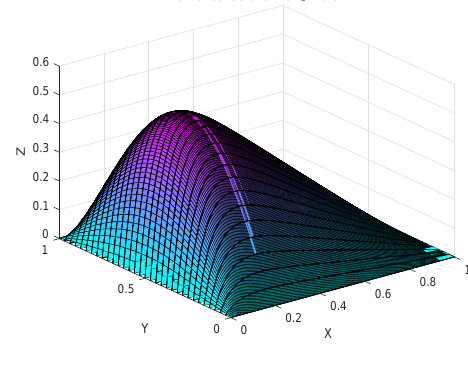
Figure 4. Example 2.